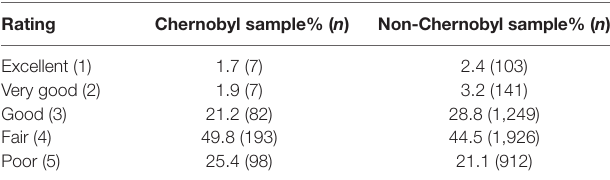
TaBle 5 | Distribution of rate-health